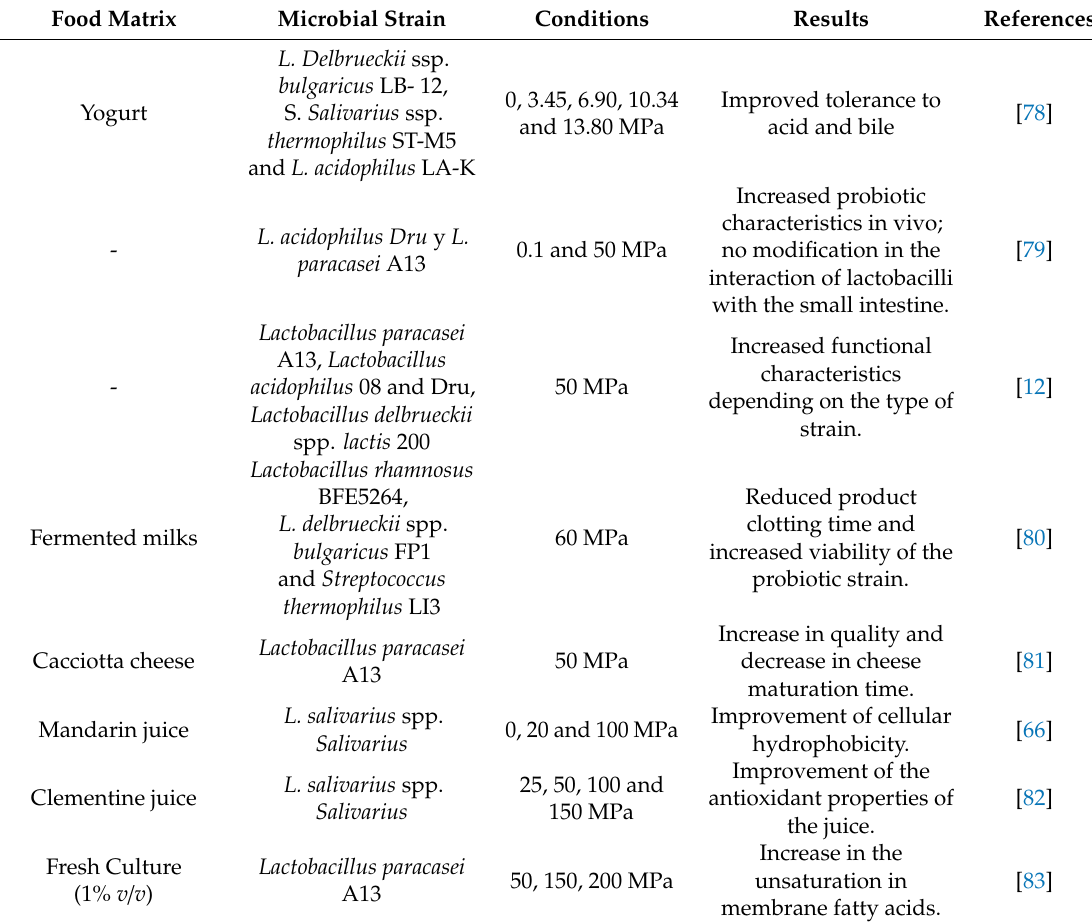
Table 5. Research works in which HPH treatment was applied to probiotic cells. Food